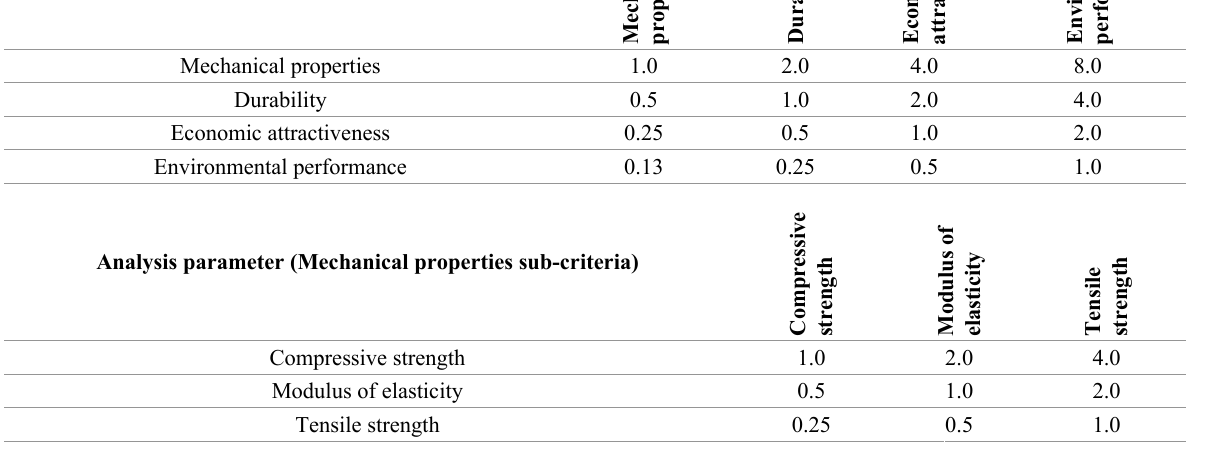
Analysis parameter (Main